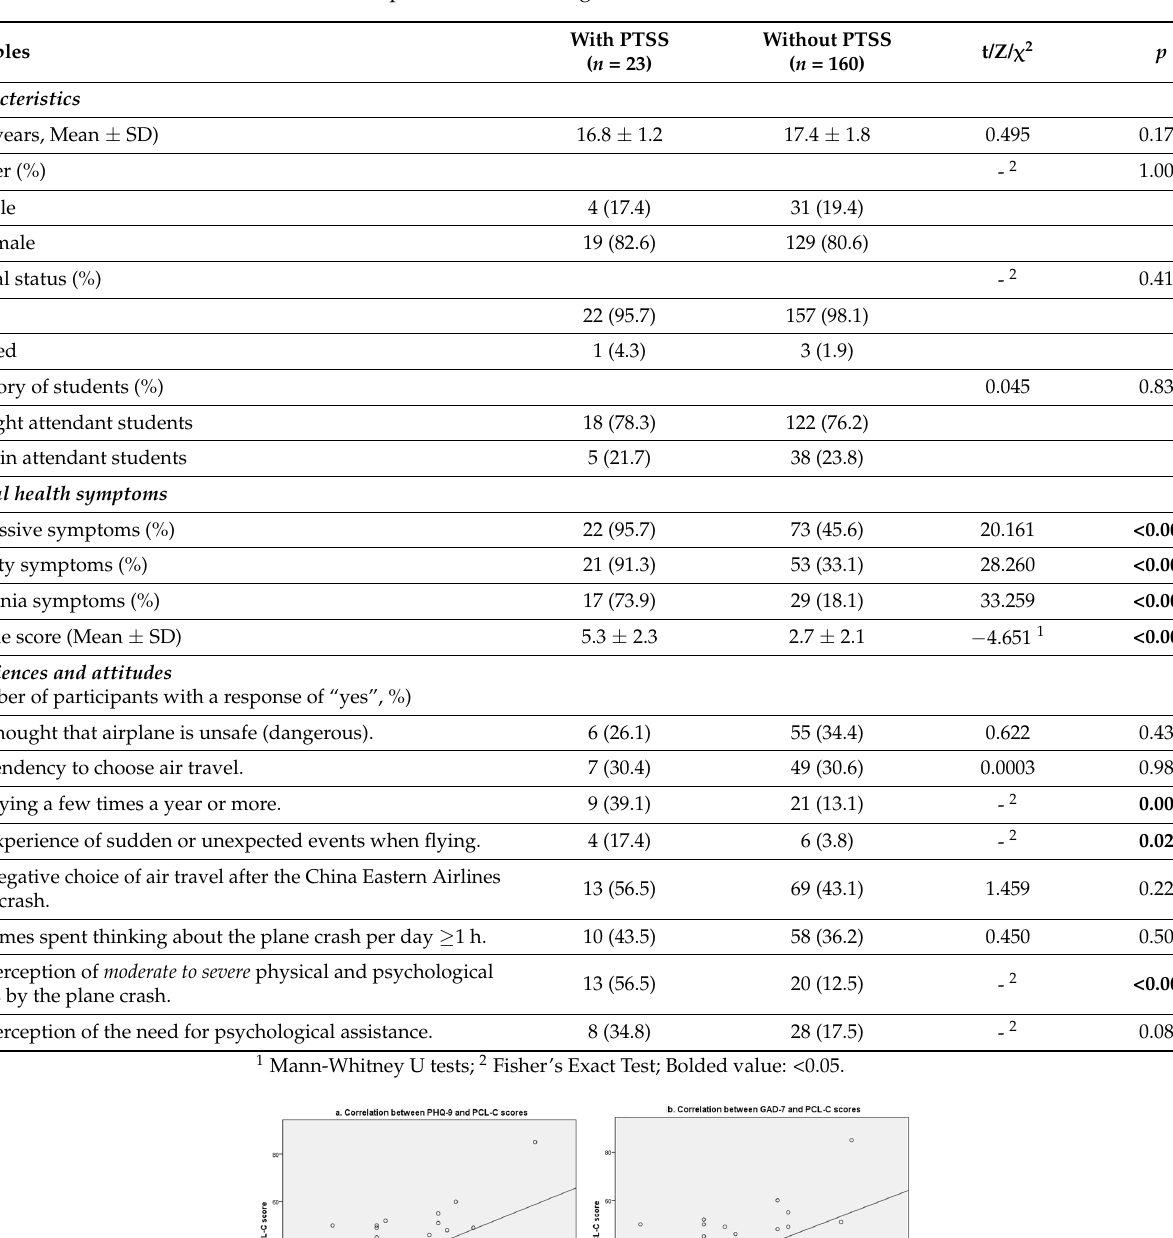
Table 4. Comparison between flight and train attendant students with PTSS and those without.